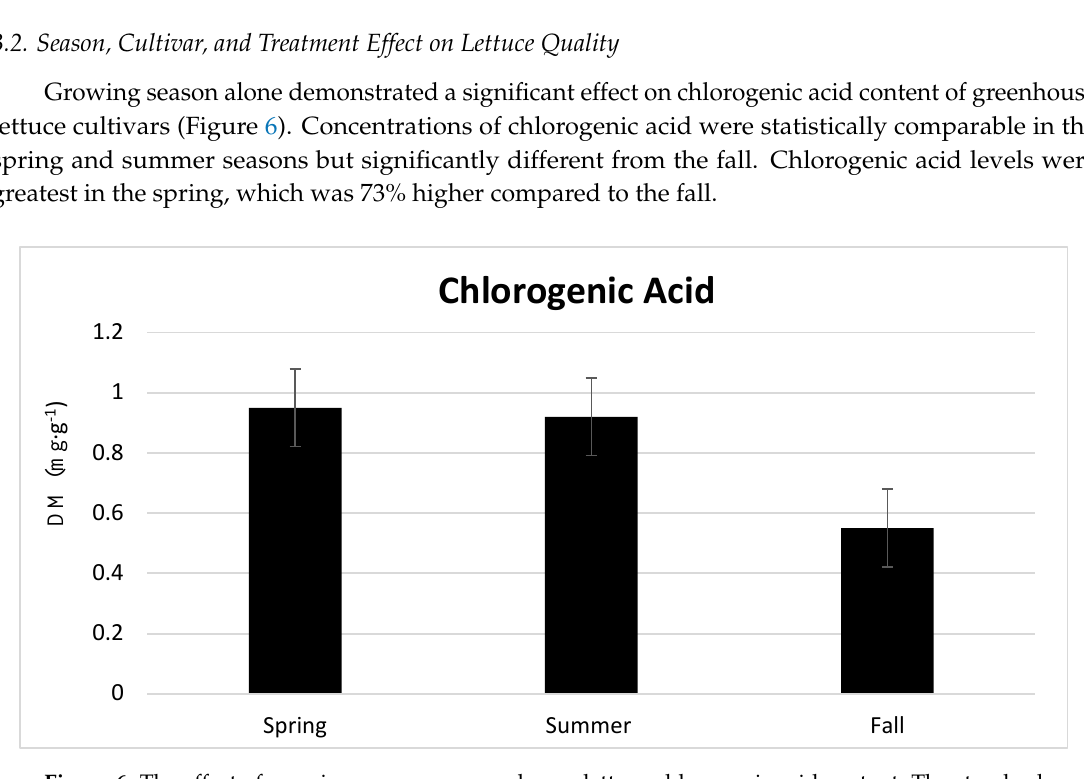
Table 3. The effect of seasons and cultivars on concentrations of greenhouse lettuce phenolics and flavonoids.